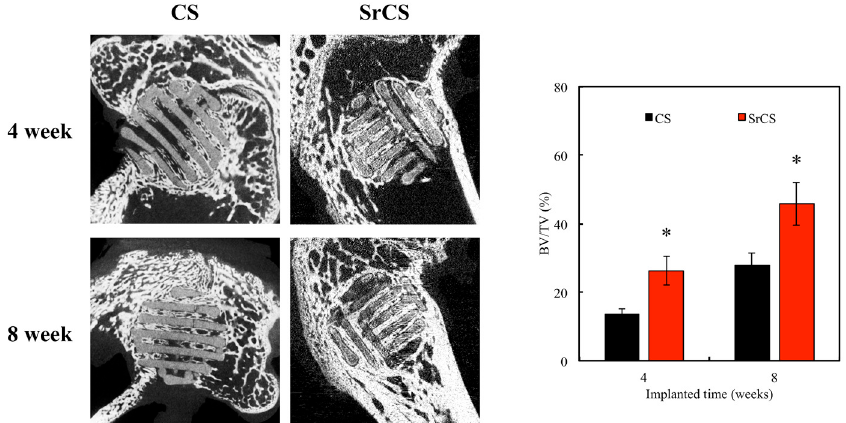
Figure 13. The µ-CT image showing the morphology of bone growth at fixed sized critical lesion after undergoing 4- and 8-weeks of regeneration with CS and SrCS scaffolds. Data analysis of relative bone mass volume (BV/TV) at fixed sized critical lesion after regeneration. “*” indicates a significant difference ( p < 0.05) when compared to CS.